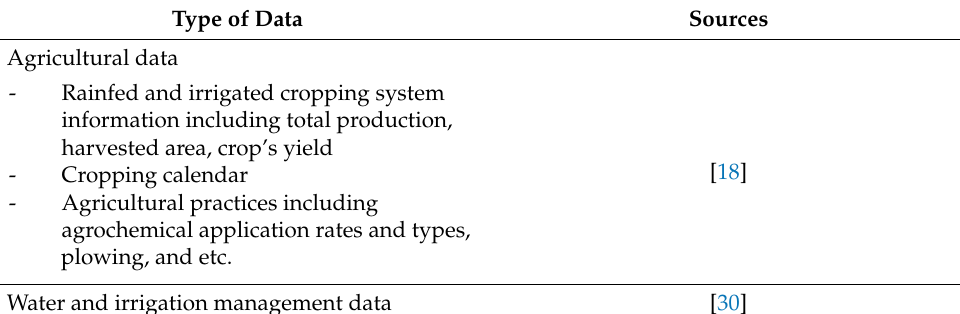
Table 4. Type and source of